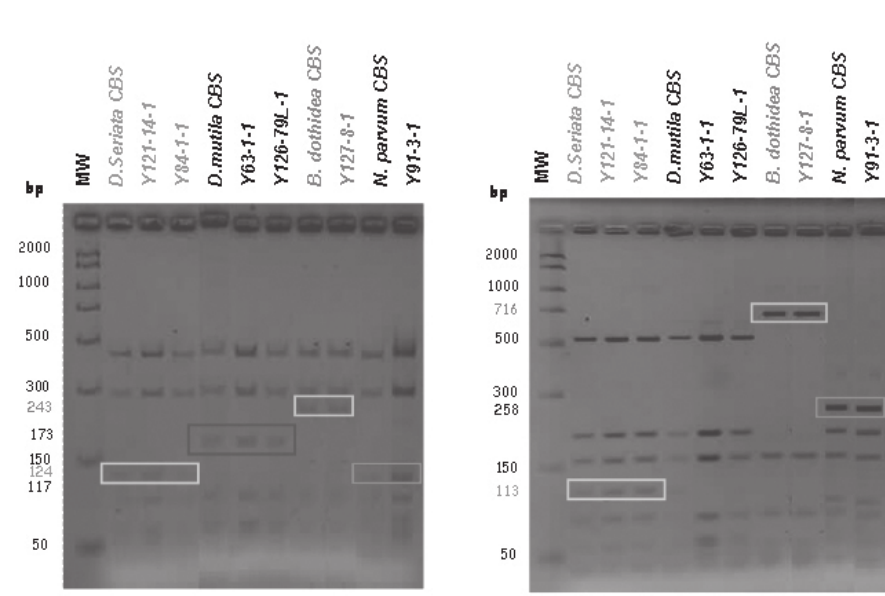
Fig. 2. Endonuclease restriction patterns TaqI, and BsuRI, for distinguishing between different Botryosphaeria -like